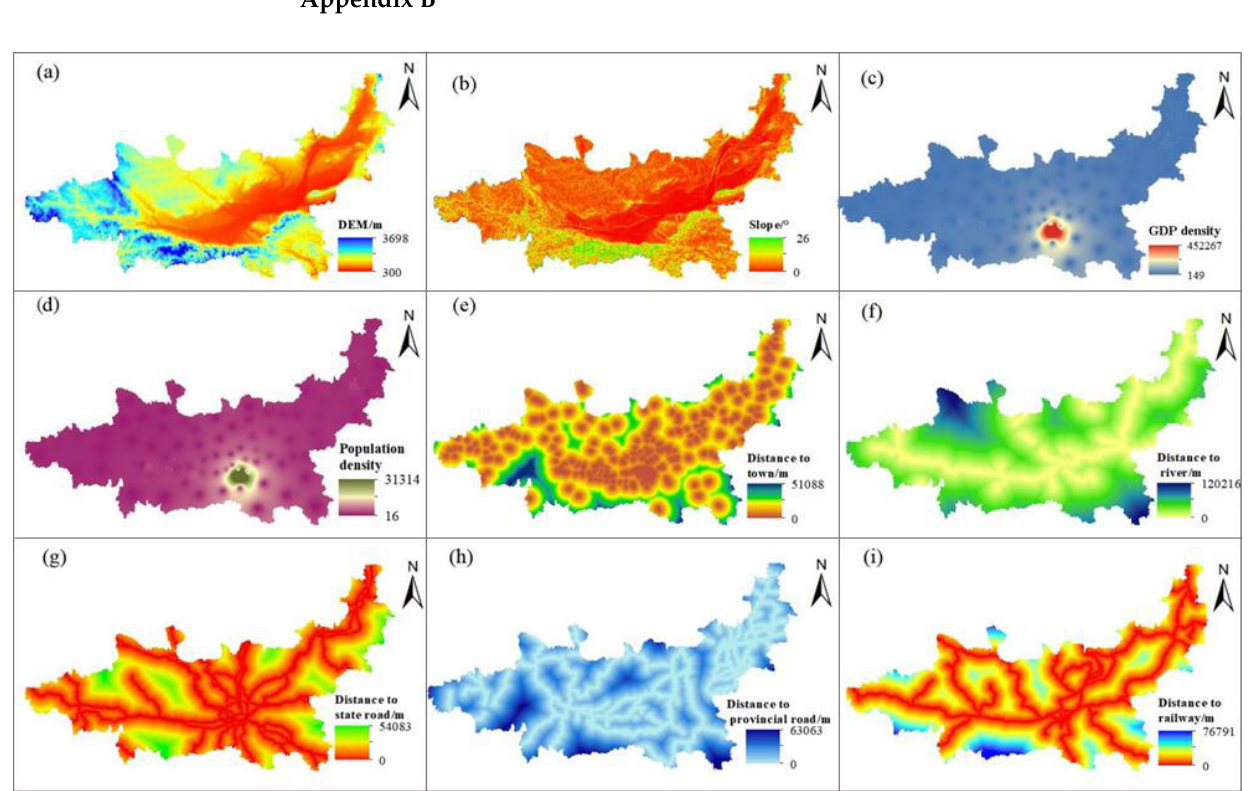
Figure A1. Driving factors of land use in the Guanzhong Plain urban agglomeration: ( a ) elevation; ( b ) slope; ( c ) GDP density; ( d ) population density; ( e ) distance to town; ( f ) distance to river; ( g ) distance to state road; ( h ) distance to provincial road; ( i ) distance to railway.